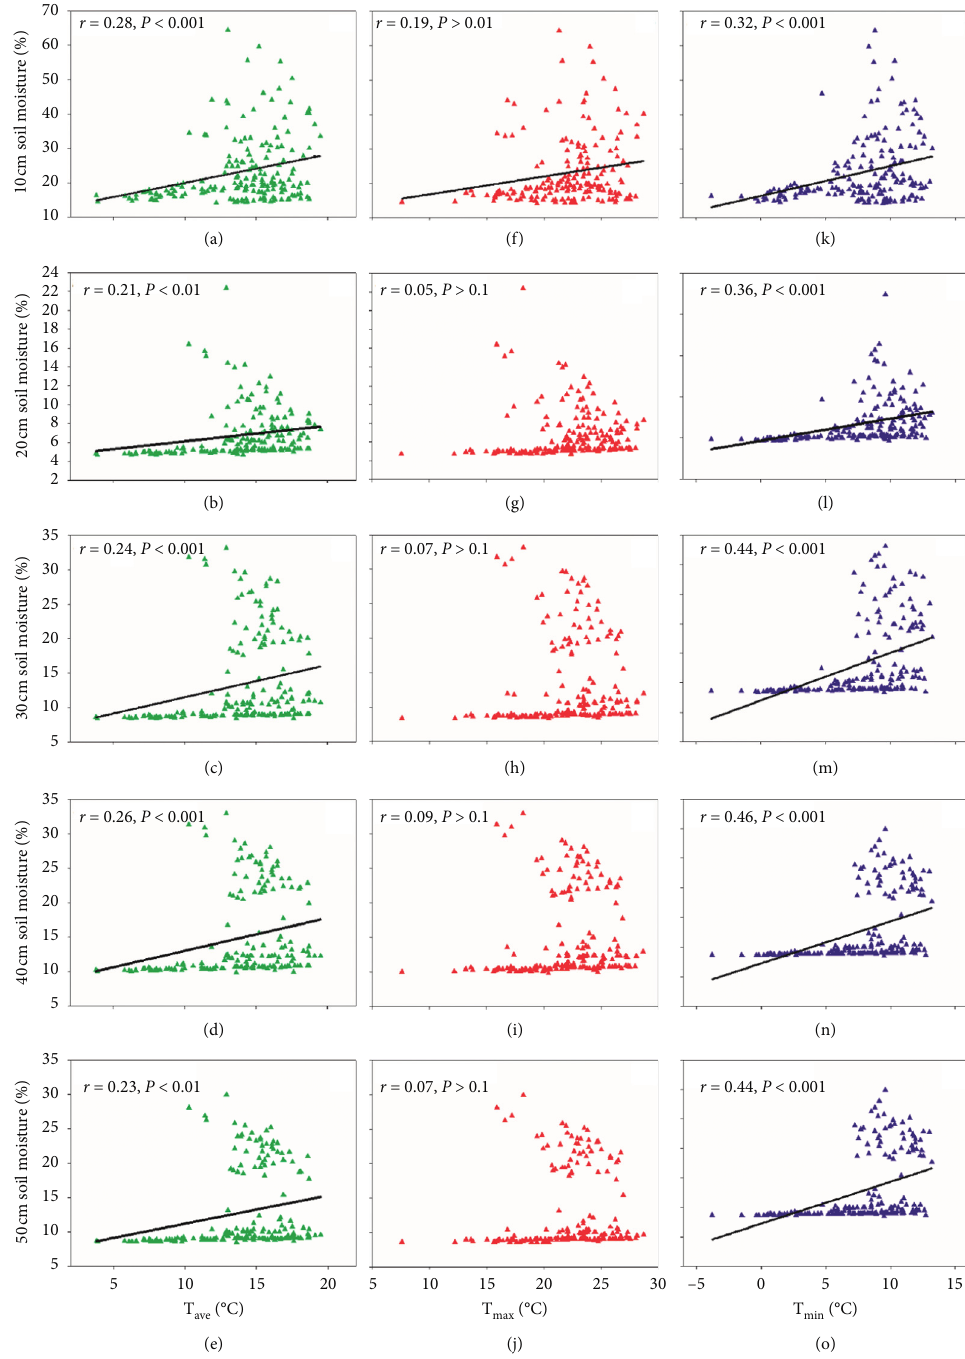
Figure 3: Correlations between air temperature and soil moisture at